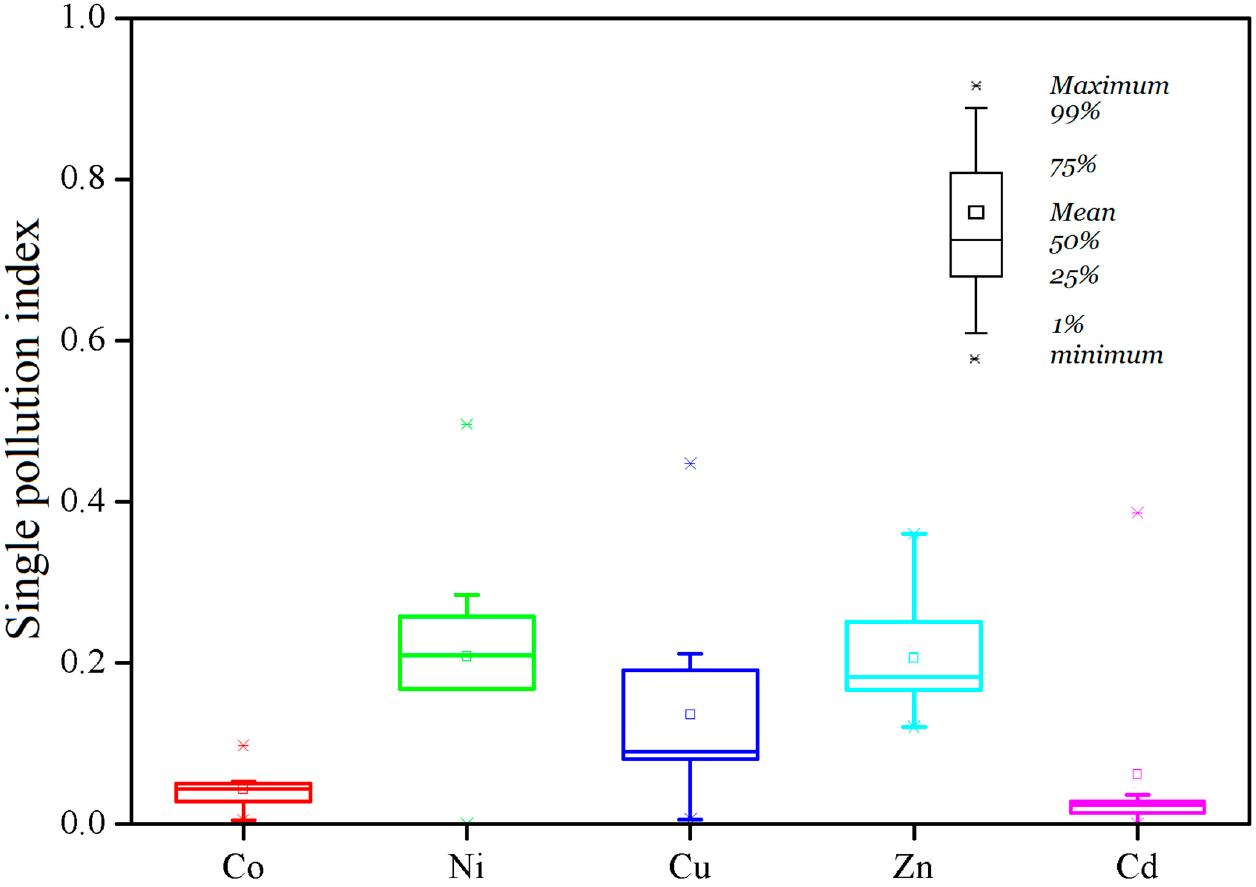
Figure 2. Single pollution indexes of heavy metals in winter jujube fruits.